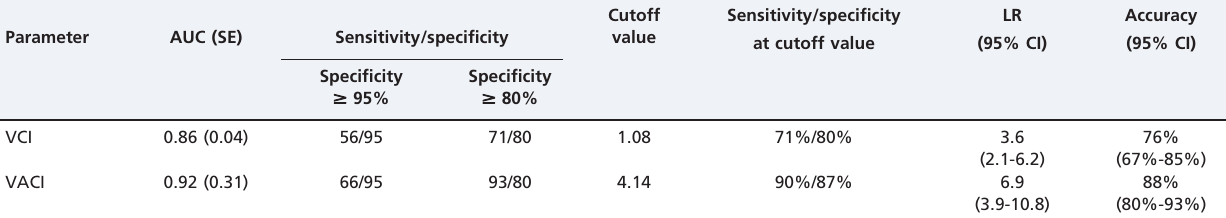
Table 2 - Area under the receiver operating characteristics curves (AUC) and sensitivities at fixed specificities for the volumetric crowding index (VCI) and the volumetric apical crowding index (VACI). Sensitivity, specificity, likelihood ratio (LR) and accuracy are presented for the best cutoff values of VCI and